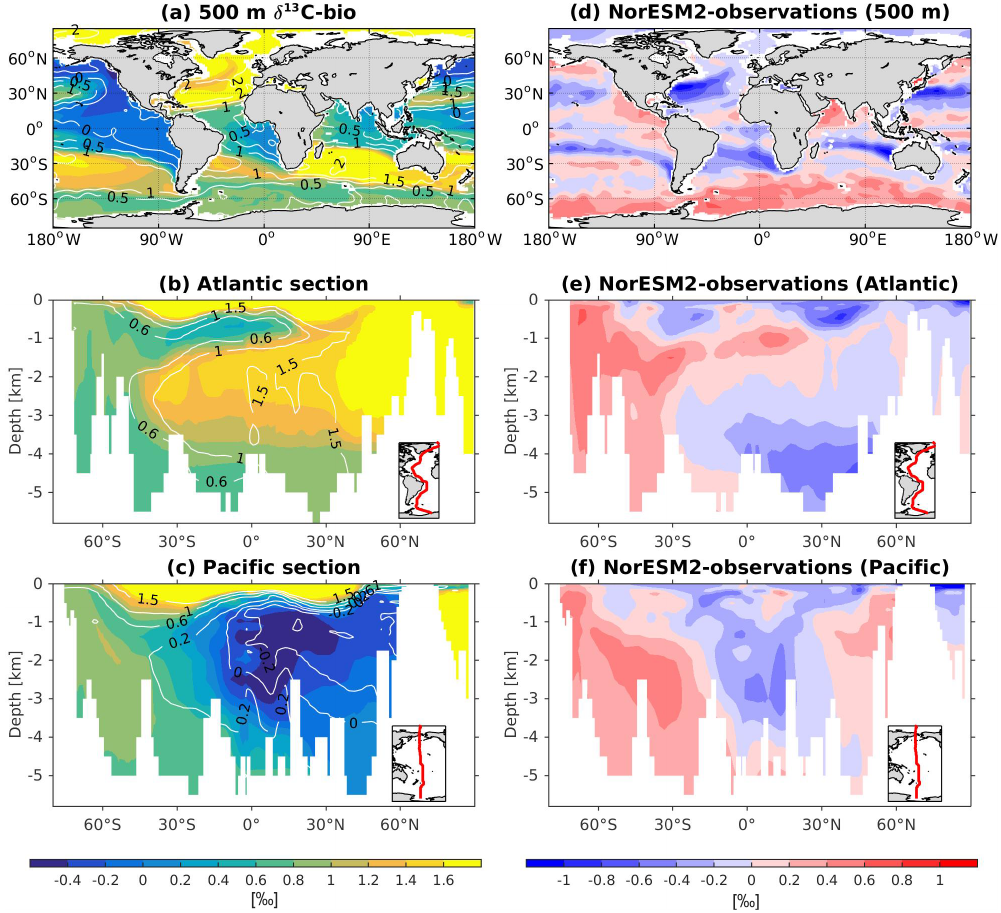
Figure 22. Climatological fields of the biological component of δ 13 C (i.e. δ 13 C BIO ) at (a) 500m of depth and across the vertical sections of (b) the Atlantic and (c) Pacific from NorESM2-OC (colour shadings) and observations (contour lines). Differences between NorESM2-OC and observations are shown as colour shadings in panels (d) – (f)